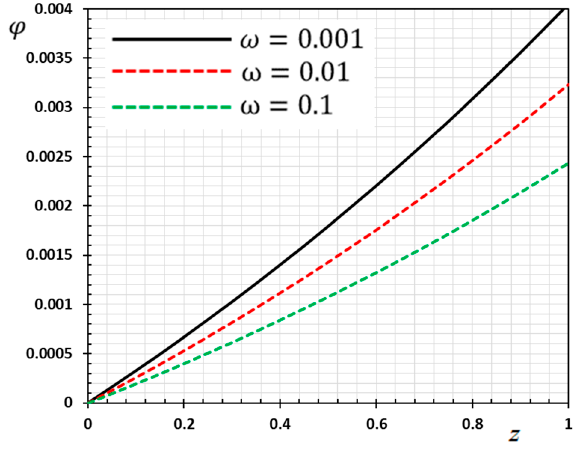
Figure 7. Variation of thermal stress σ zz versus z for di ff erent delay time ω . Figure 7. Variation of thermal stress 𝜎 (cid:3053)(cid:3053) versus 𝑧 for different delay time 𝜔 . Figure 7. Variation of thermal stress 𝜎 (cid:3053)(cid:3053) versus 𝑧 for different delay time 𝜔 .